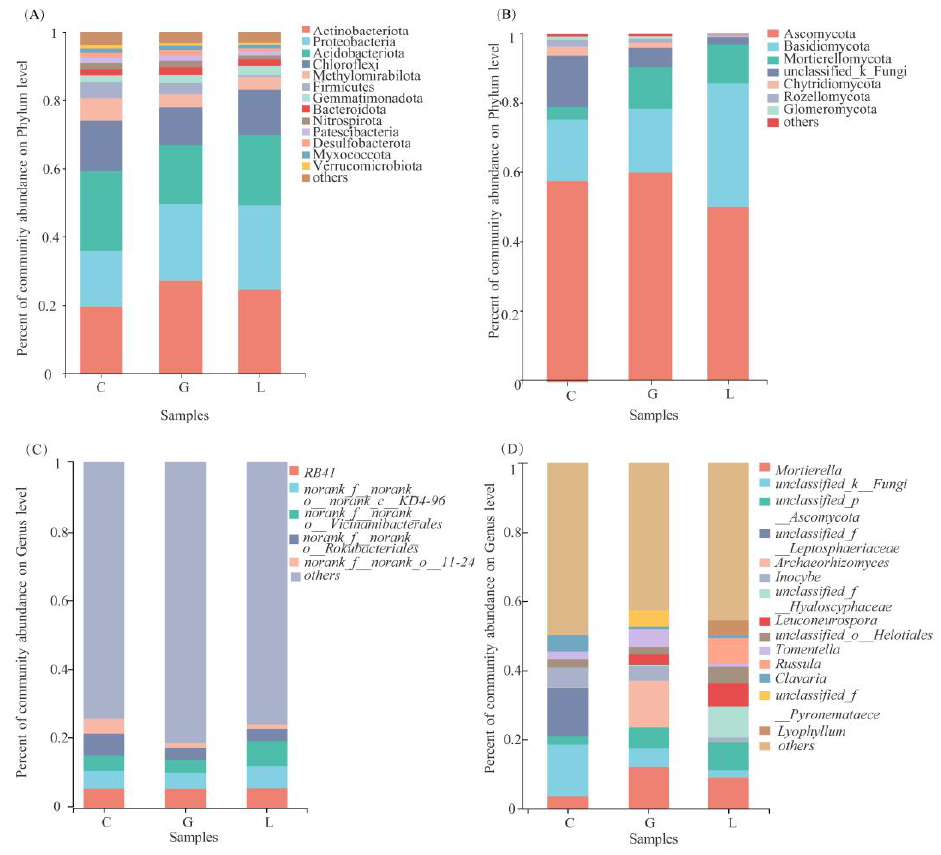
Figure 6. ( A , B ) Bacteria ( A ) and fungi ( B ) with relative abundance greater than 1% at phylum level in three planting coverts; ( C , D ) bacteria ( C ) and fungi with relative abundances greater than 4% at genus level in the three planted coverts ( D ).